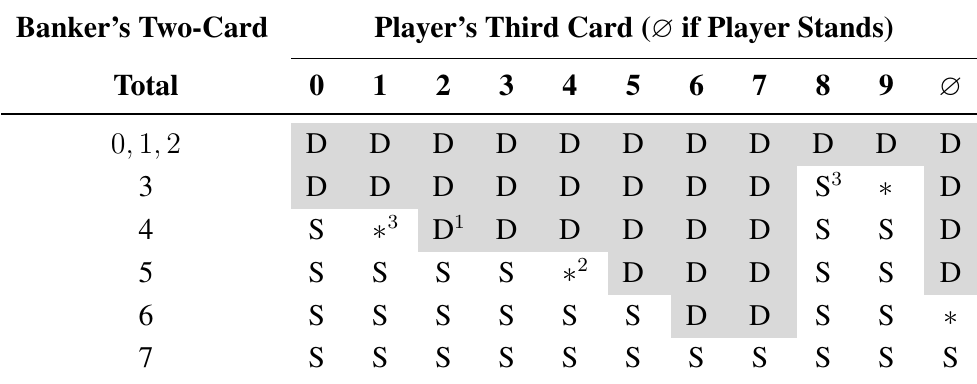
= 4 cases indicated by in which it depends on 6 ⇤ 4